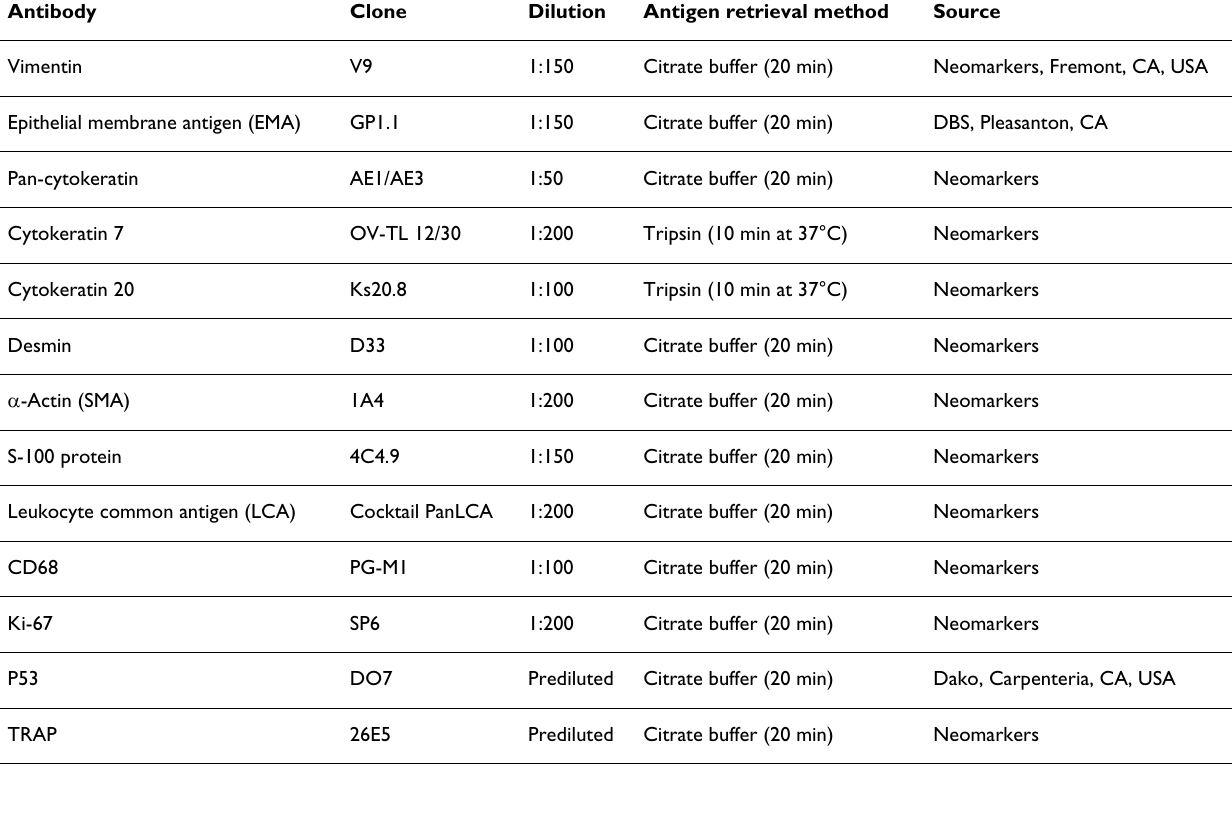
Table 1: List of Antibodies for Immunohistochemical Studies Antibody Clone Dilution Antigen retrieval method Source Vimentin V9 1:150 Citrate buffer (20 min) Neomarkers, Fremont, CA, USA Epithelial membrane antigen (EMA) GP1.1 Pan-cytokeratin